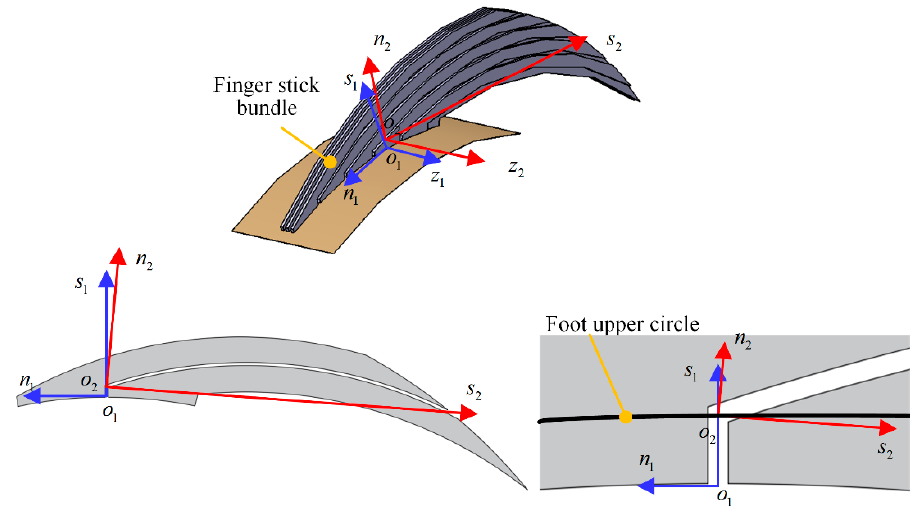
Figure 6. Principal axis directions of the two porous media equivalent to finger stick bundle.